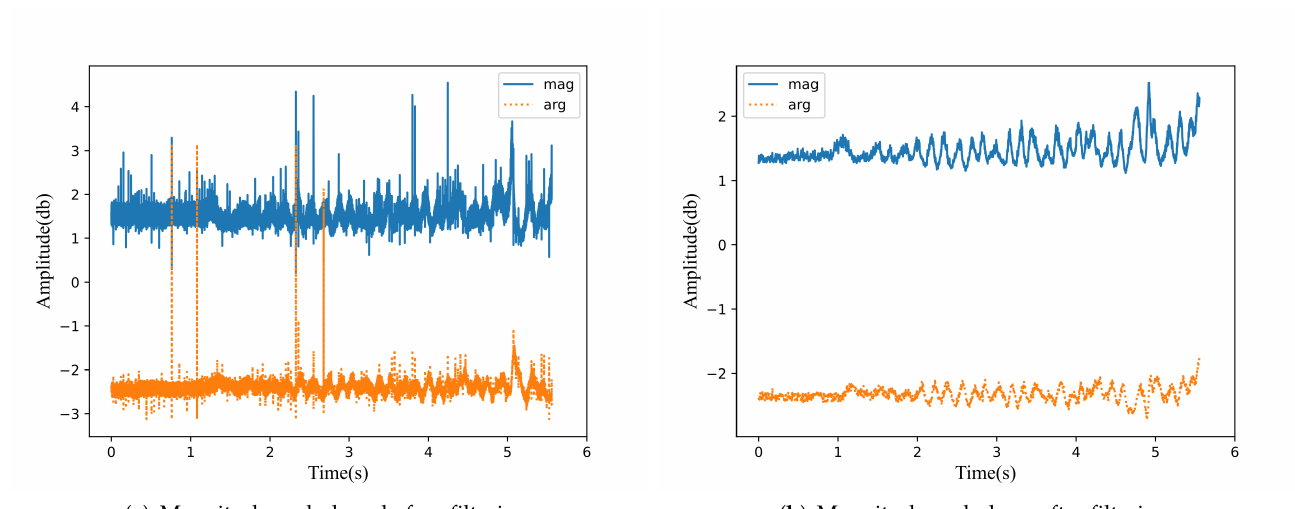
Figure 5. Waveforms of data before and after filtering of amplitude and